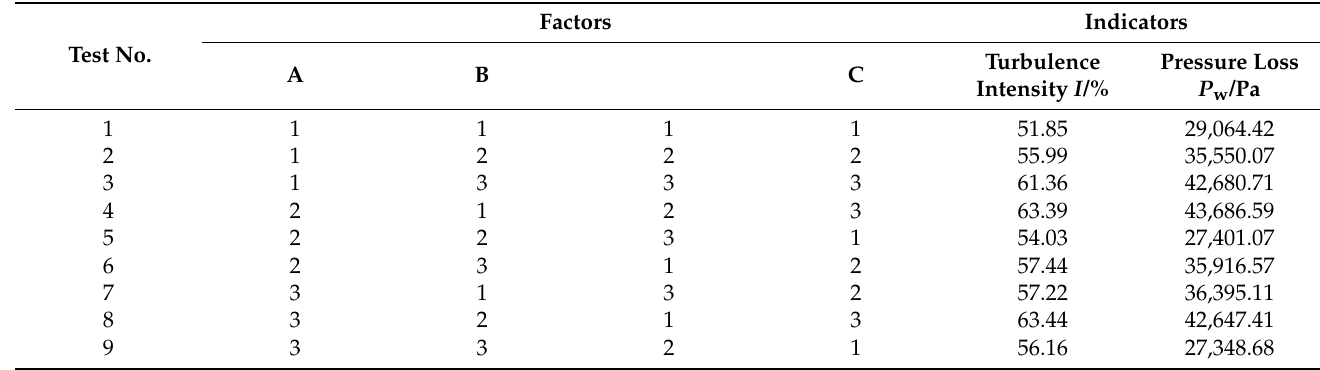
Table 5. Orthogonal test results.